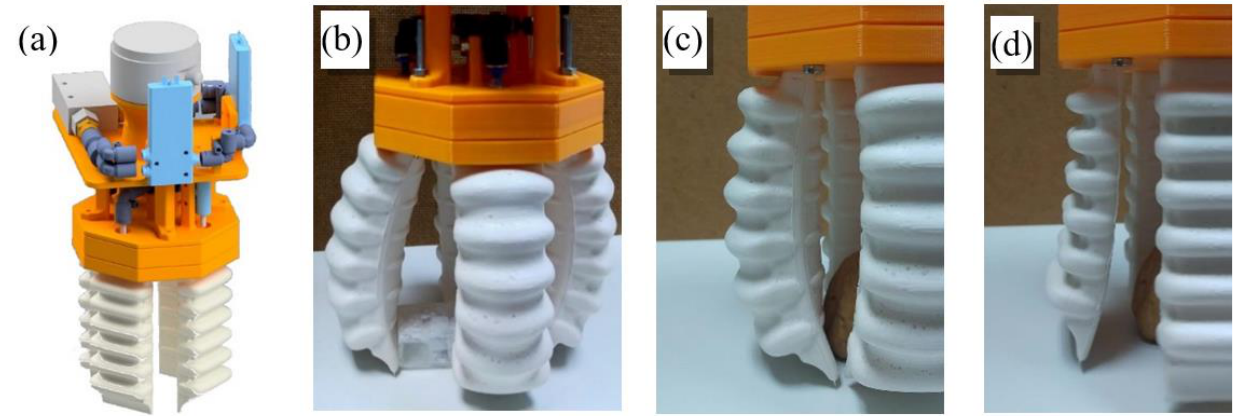
Figure 2. First gripper: ( a ) CAD model, ( b ) Gripper during the operation, ( c ) Fingers flexed, ( d ) and Fingers in extension.